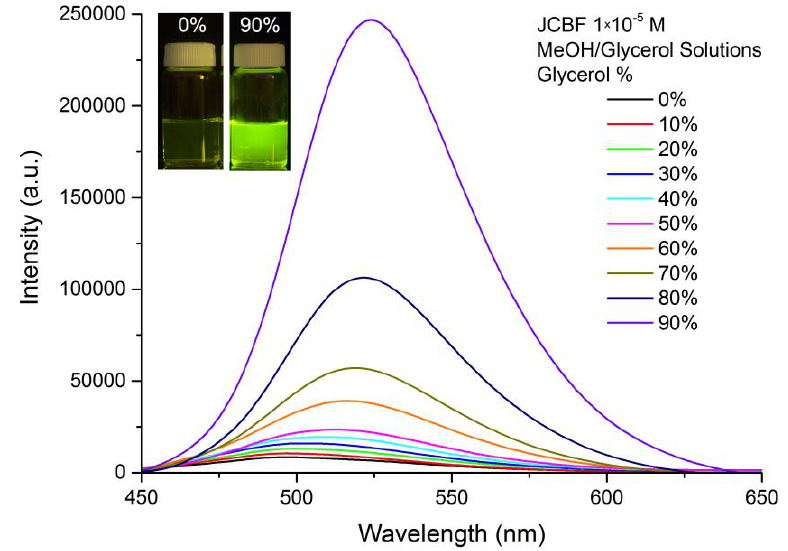
Figure 2. Fluorescence ( λ exc. = 410 nm) of 1 × 10 − 5 M JCBF in methanol/glycerol solutions with different glycerol volume contents. In the inset picture, JCBF solutions were excited with a Dark Reader 46B transilluminator (~450 nm, Clare Chemical Research, Dolores, CO 81323).